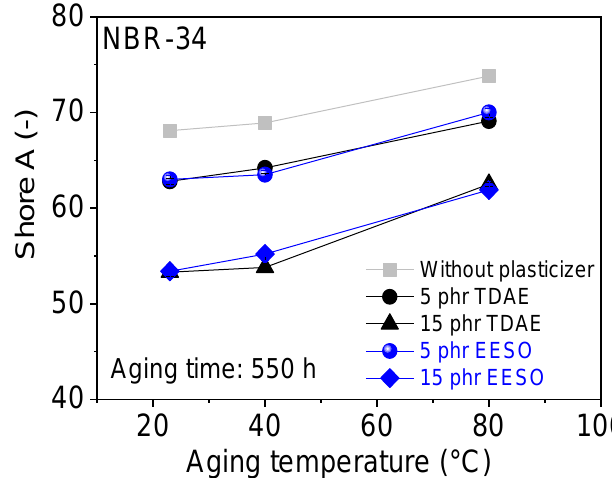
Figure 15. Shore A hardness as a function of aging temperature for NBR-34 vulcanizates with various plasticizers.